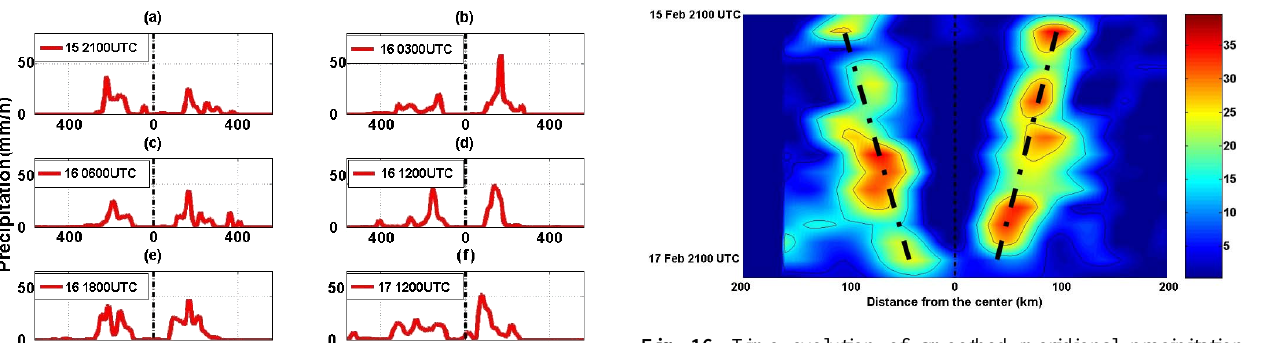
Fig. 16. Time evolution of smoothed meridional precipitation (mmh − 1 ) at the latitude of the TC centre from 15 February at 21:00UTC to 17 February at 21:00UTC. The TC centre is used as origin for distance. Dotted broken lines indicate eye